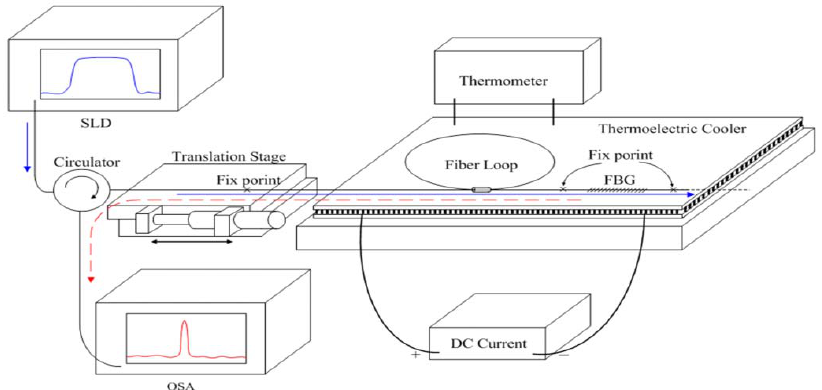
Figure 1. Experimental architecture